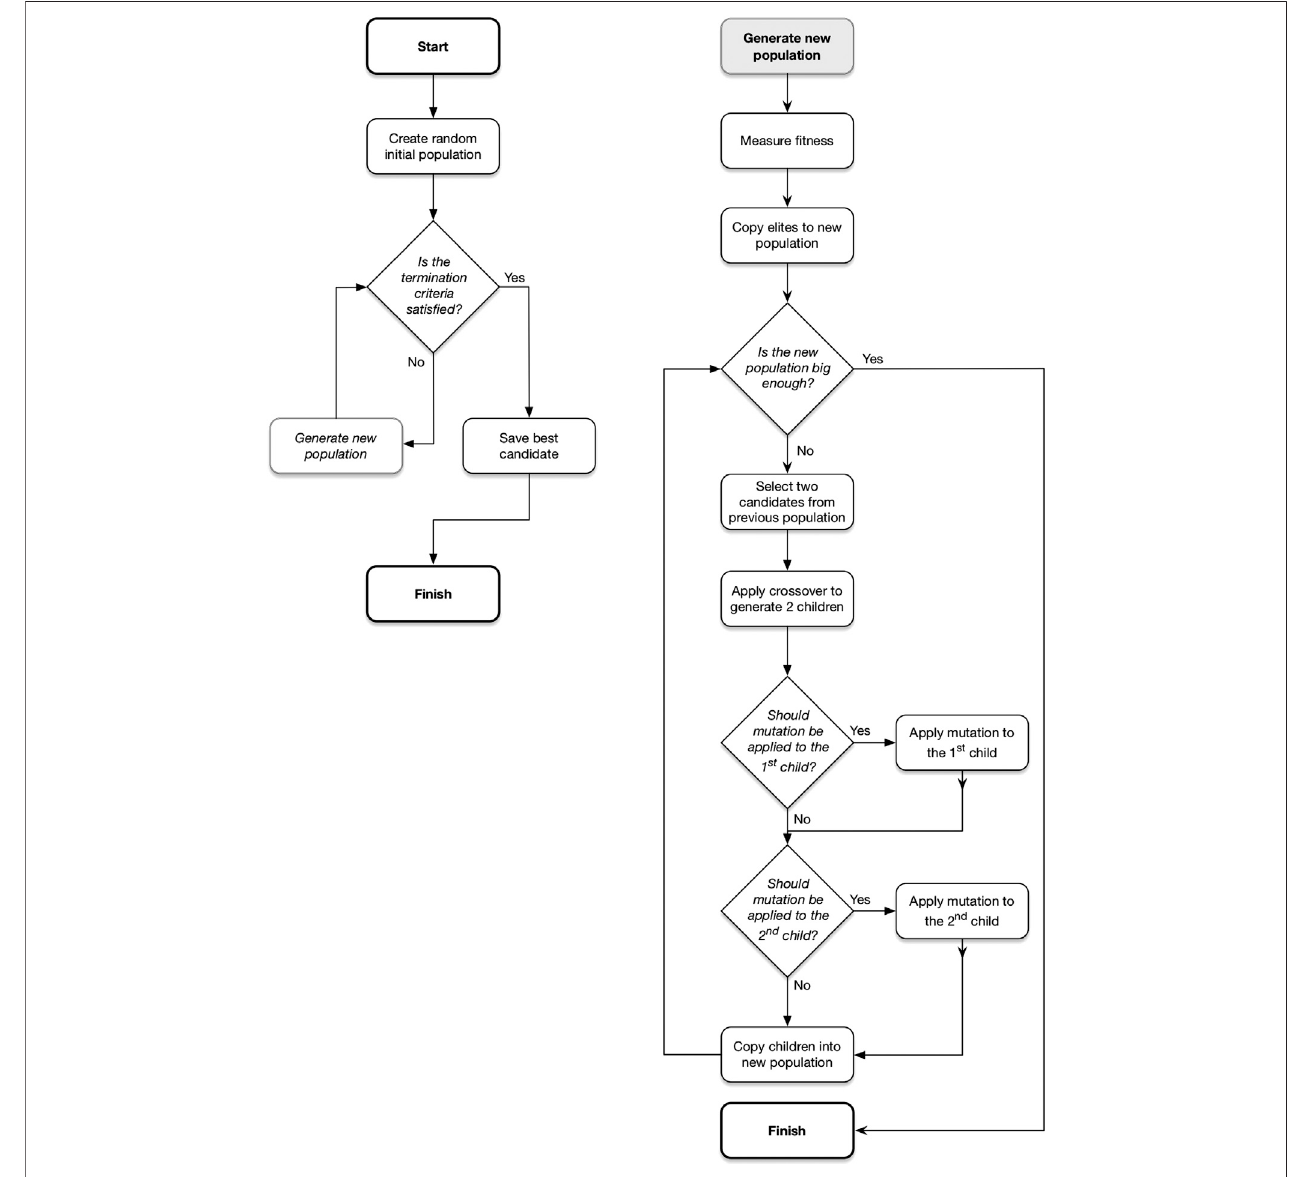
FIGURE 1 | The general process followed by an evolutionary algorithm. Recreated from Koza (2018). Note that the number of parent candidates selected and the number of children generated depends on the operator. This example shows two parents generating two offspring.